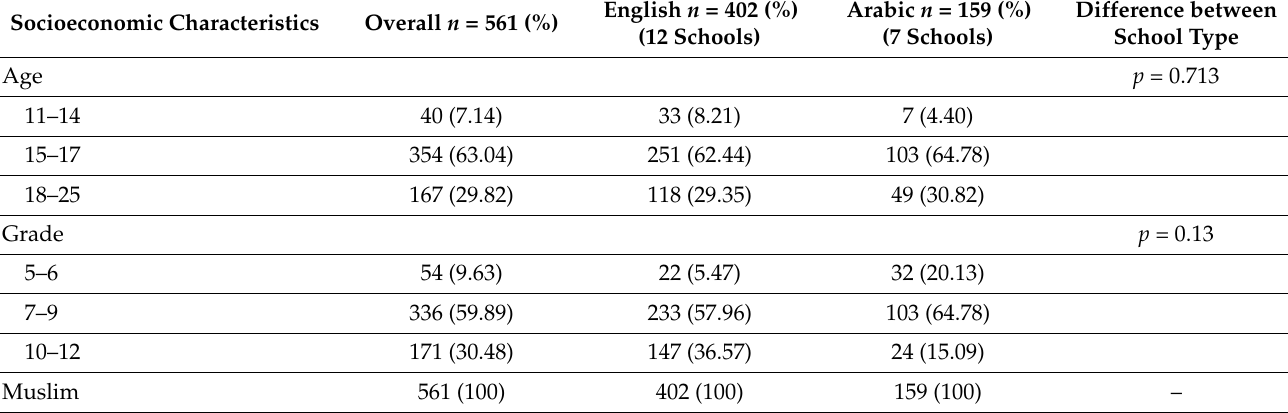
Table 2. Sociodemographic characteristics of study